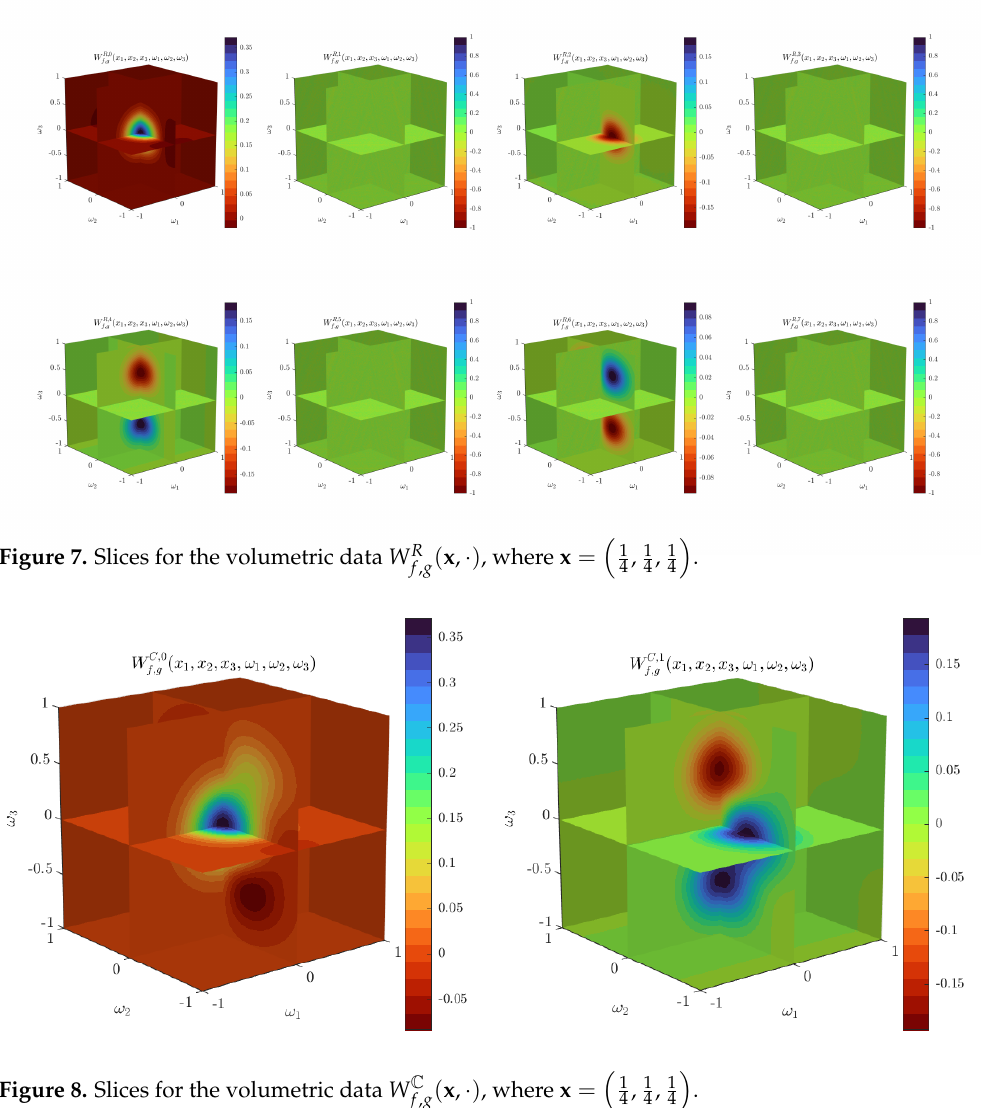
Figure 8. Slices for the volumetric data W C